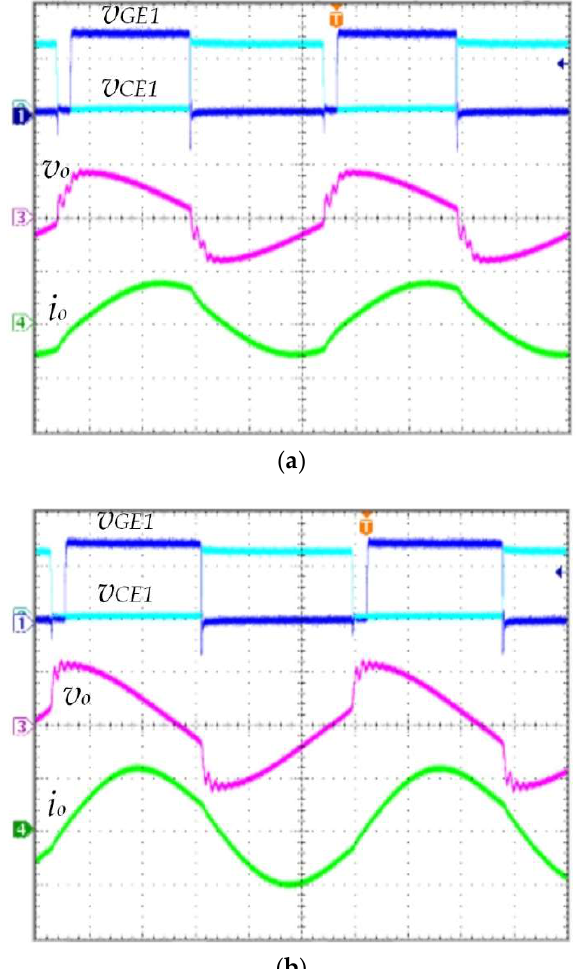
Figure 22. Hardware experimental waveforms v GE1 (duty cycle), the voltage across the power switch voltage v CE1 , the output voltage v o , and the output current i o under the condition that the workpiece is 750 °C: ( a ) traditional control strategy, ( b ) proposed MPPT heating control strategy. ( v GE1 : 10 V/div; v CE1 : 200 V/div; v o : 40 V/div; i o : 40 A/div; and Hor: 4 μs/div).